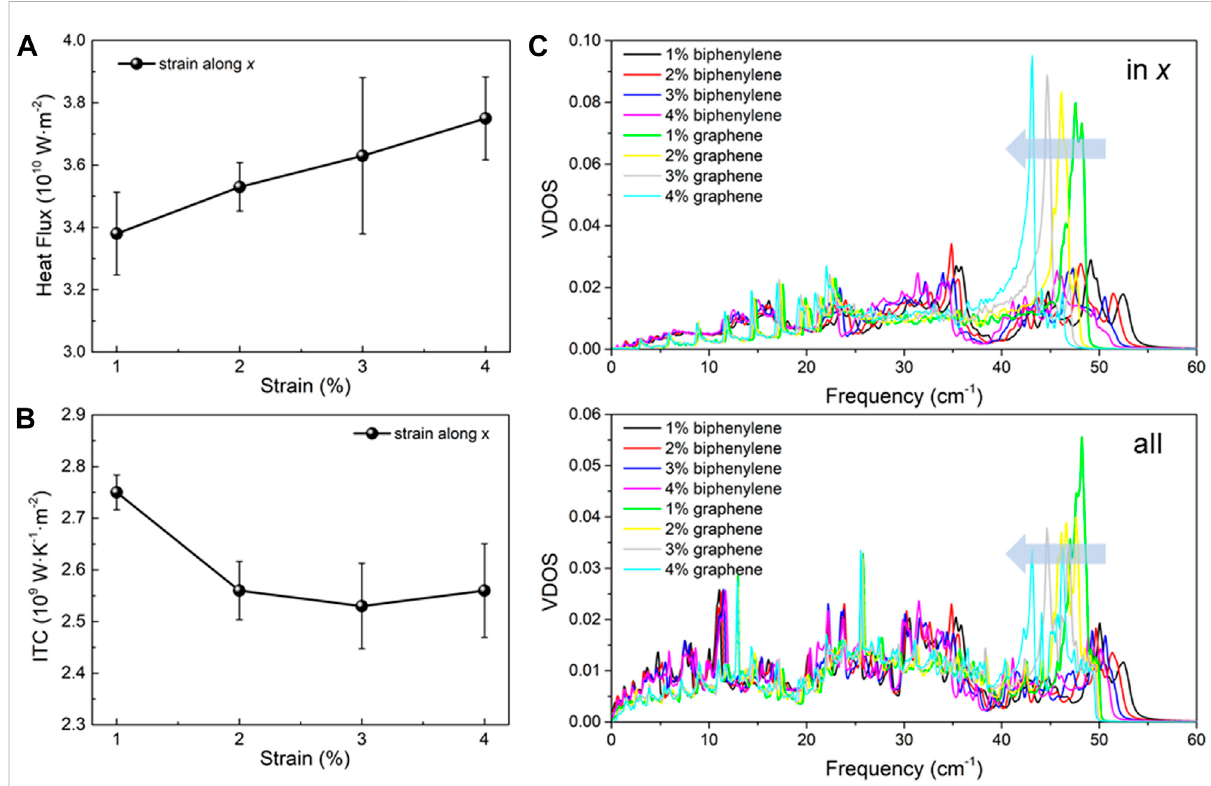
FIGURE 5 (A) Heat fl ux, (B) interfacialthermalconductance,and (C) VDOSofthebiphenylene/graphenelateralheterostructureunderexternalstrainalong the x